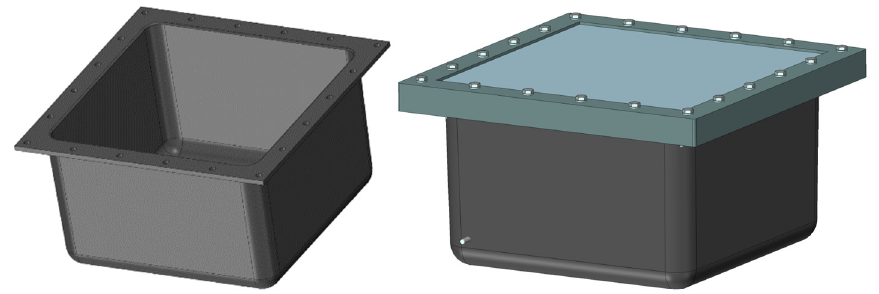
Figure 17. Enclosure model.